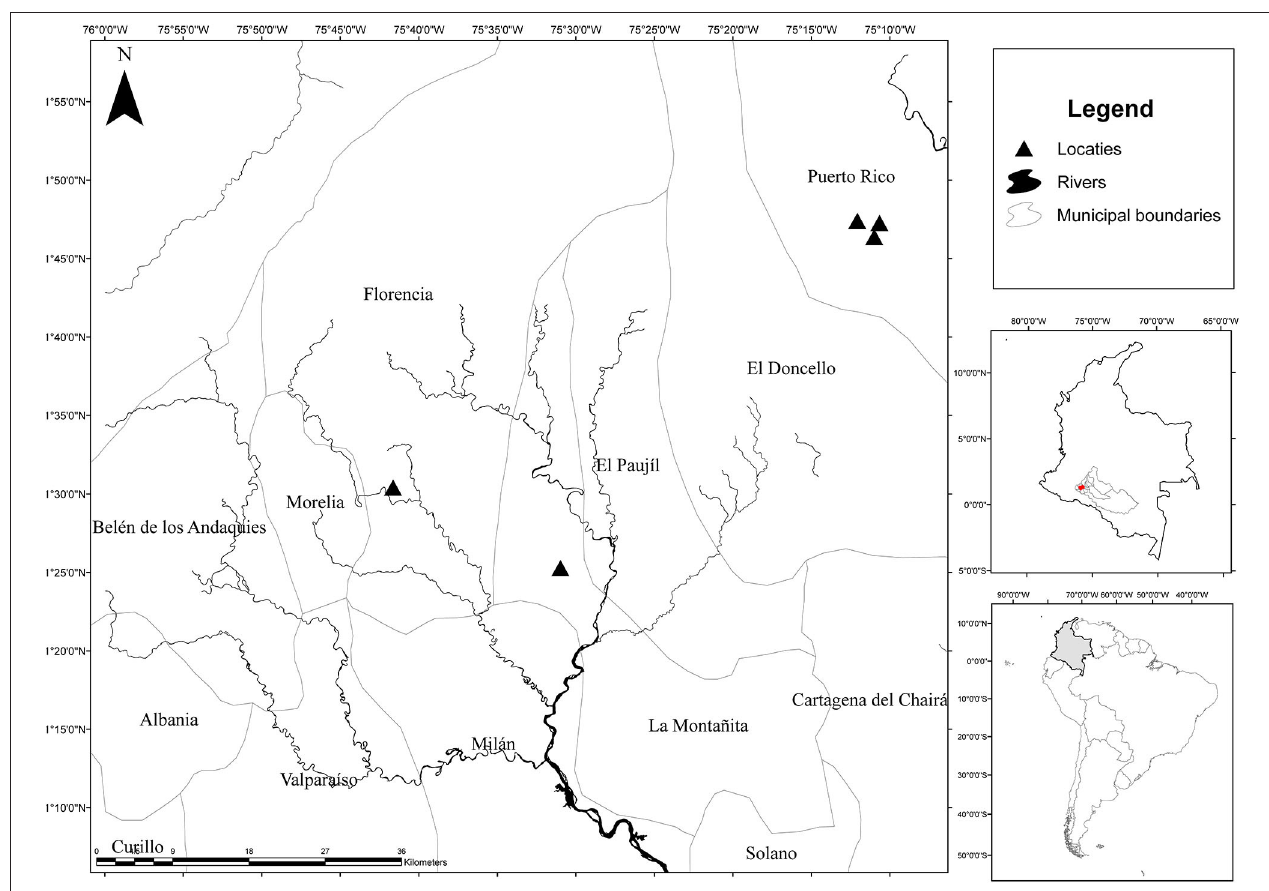
FIGURE 1 | Location of sampling sites in Caquetá department,